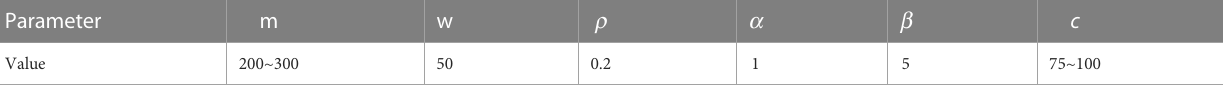
TABLE 1 Related parameter values of improved ant colony algorithm. Parameter